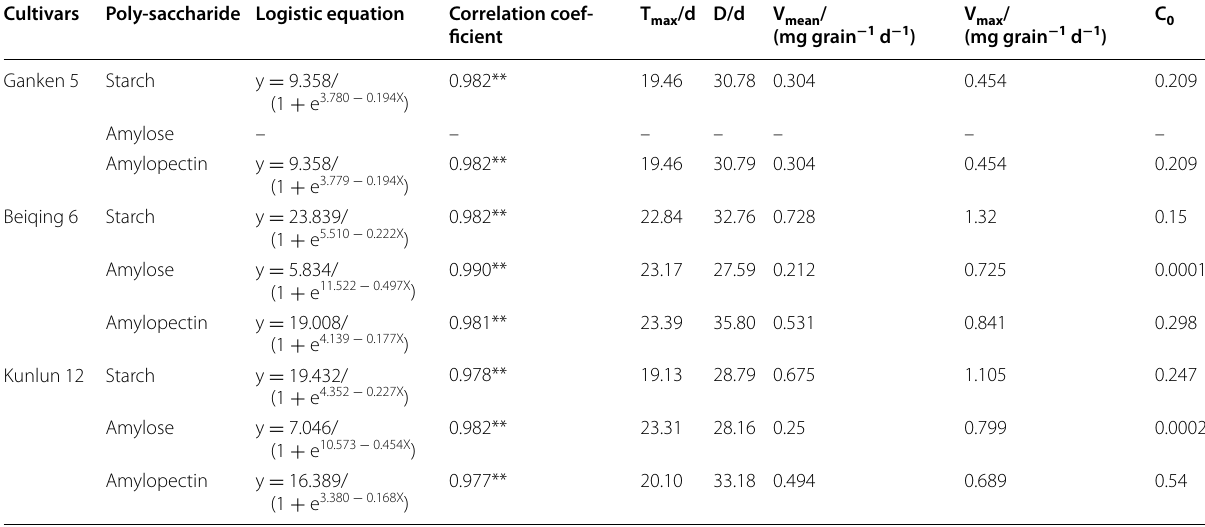
y, grain starch accumulation; x, days after anthesis T max time to reach the maximum accumulation rate, D accumulation duration, V mean mean accumulation rate, V max maximum accumulation rate, C 0 initial growth potential ** Significant at the 0.01 probability level